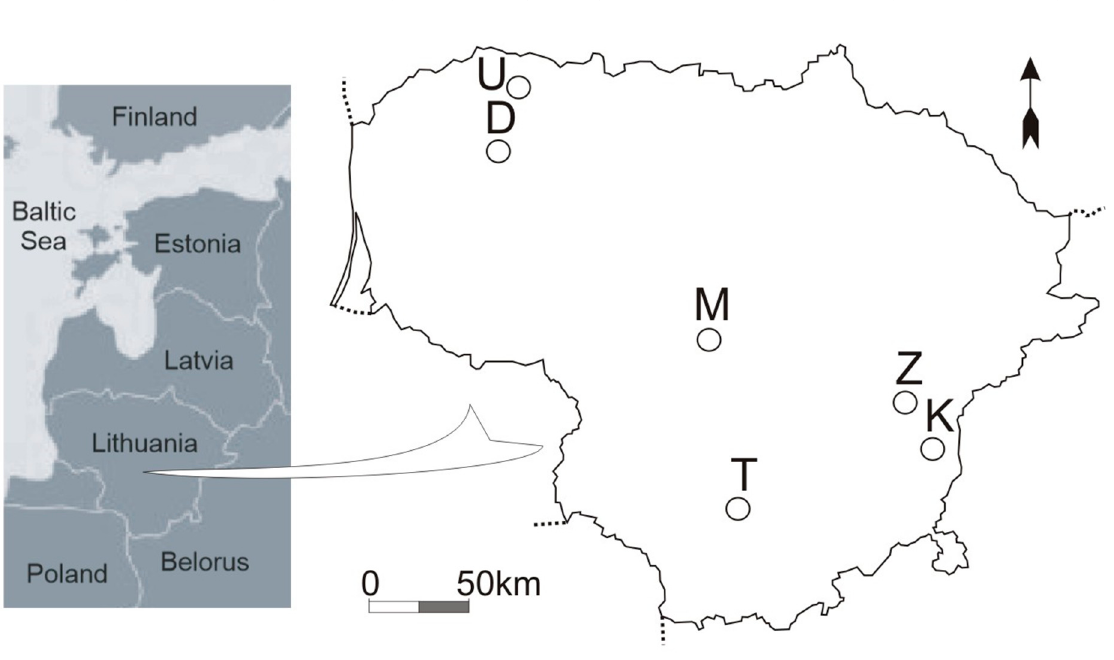
Figure 2. Distribution of the relevant stretches in the territory of Lithuania.